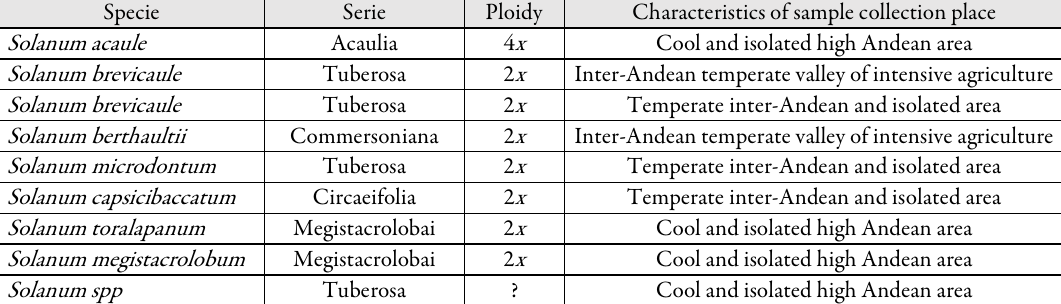
Table 2. Taxonomy group, ploidy of each specie collected and the Agro ecological characteristics of each collection place. Years: 2017 to 2018